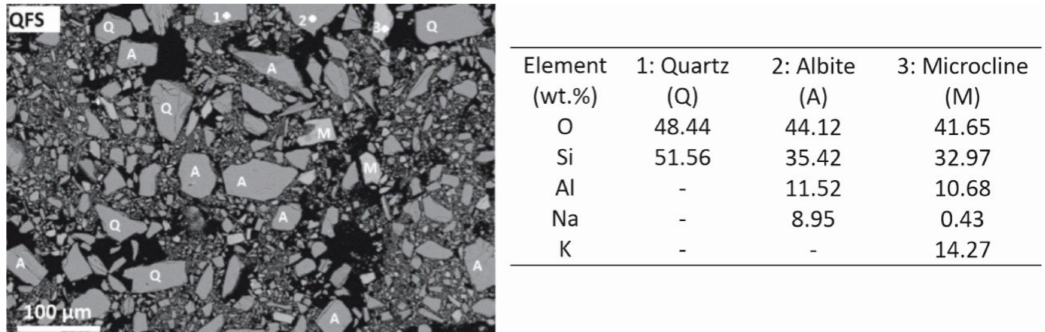
Figure 6. SEM of QFS powder [112].